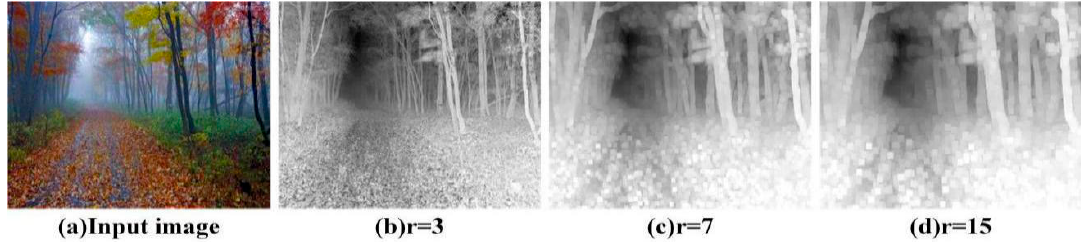
Figure 4. The DCP color feature maps.